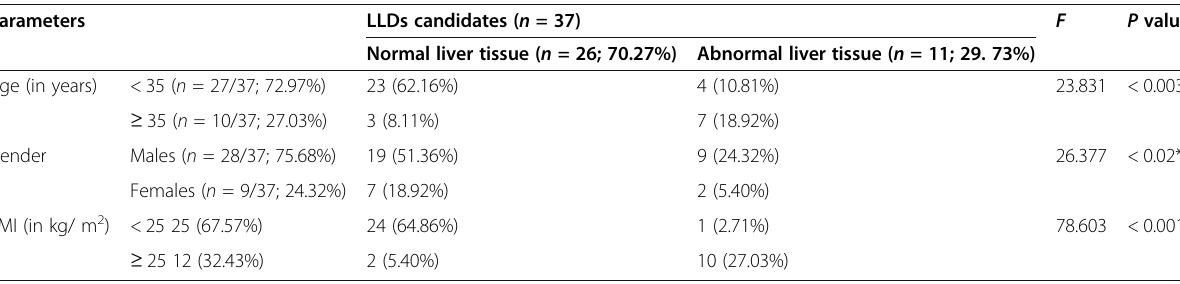
Table 2 Distribution of the studied LLD candidates according to their age, gender, and BMI ( n = 37)